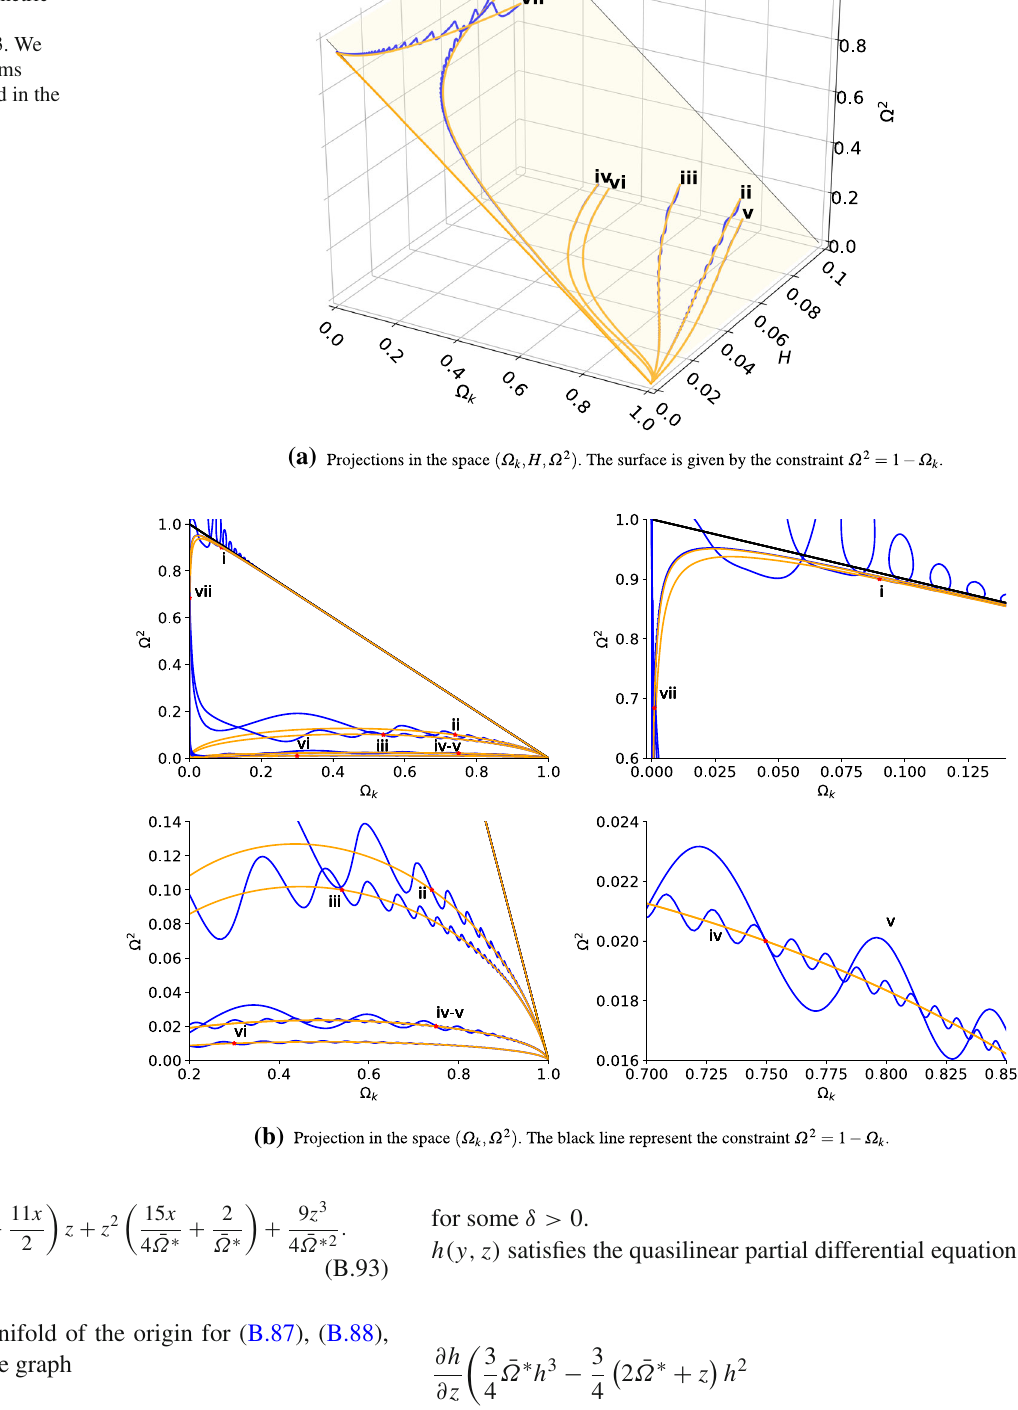
Fig. 23 Some solutions of the full system (71) (blue) and time-averaged system (107) (orange) for the FLRW metric with negative curvature ( k = − 1) when γ = 4 / 3. We have used for both systems initial data sets presented in